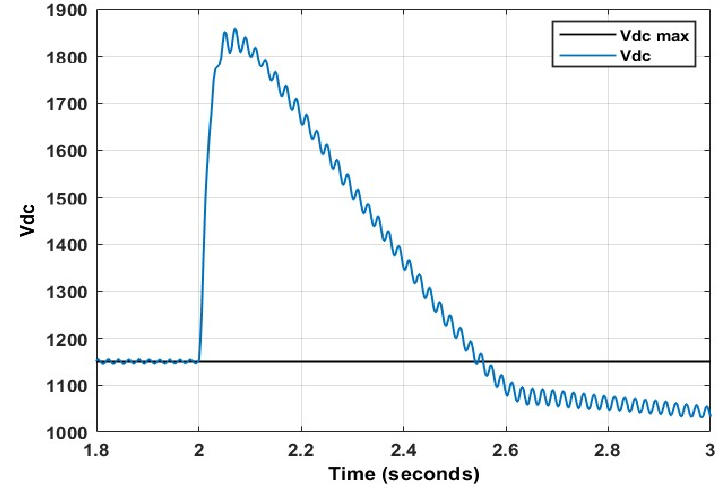
Figure 18. DC voltage transient using PSO at 90% dip.